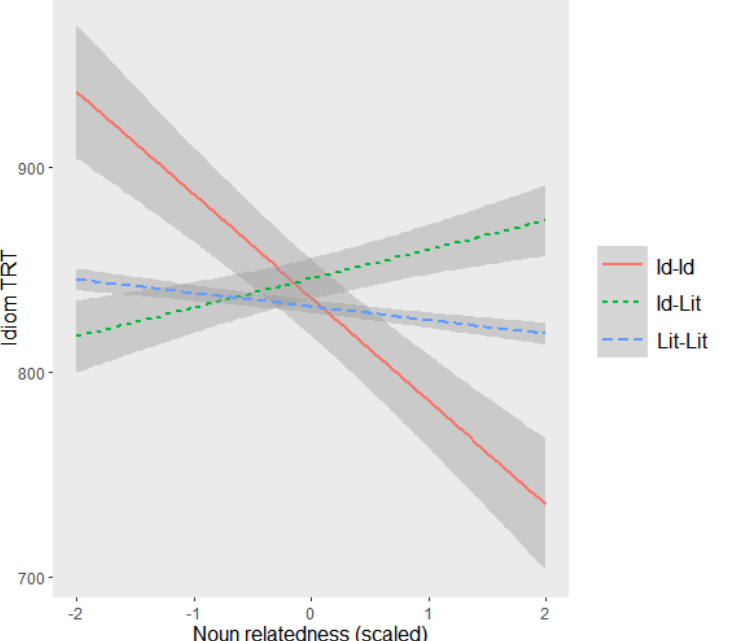
Figure 3. Partial effects plot of total reading time of the whole idiom region as a function of noun relatedness ( x -axis) for the Idiomatic–Idiomatic (Id-Id), Idiomatic–Literal (Id-Lit) and Literal–Literal (Lit-Lit) conditions. Error shadings reflect ± 1 standard error of the mean.